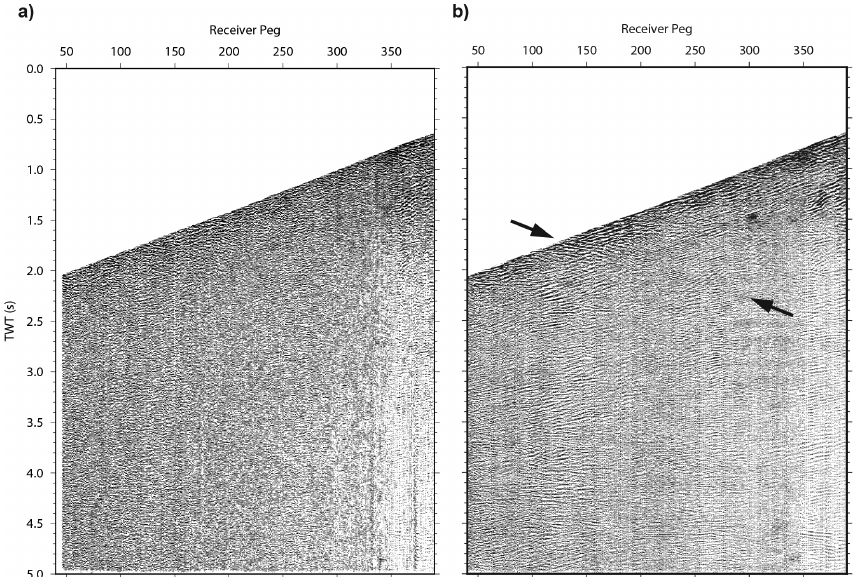
Figure 4. Application of FX-decon in pre-stack processing (a) before and (b) after FX-decon. The arrows show an enhanced reflection which is exposed at about receiver peg 105 at the surface and corresponds to the main east-dipping Pärvie fault (see the location of the receiver in Fig. 2).